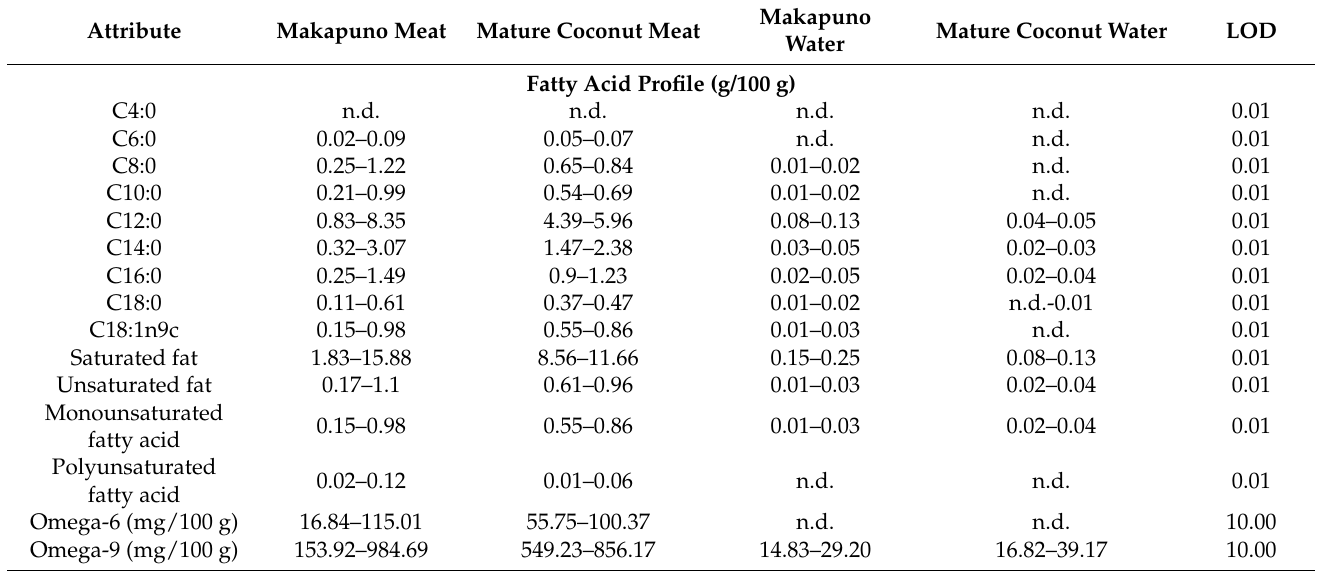
Table 2. Fatty acid profiles in the coconut